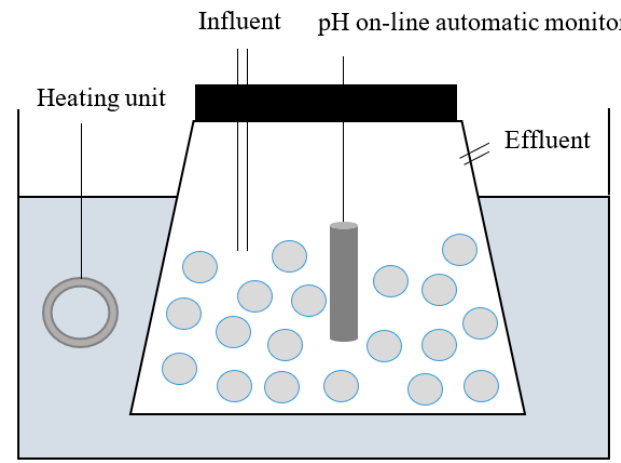
Figure 1. Schematicdiagramshowingtheexperimentalanaerobicammoniumoxidation(anammox)reactor. Figure 1. Schematic diagram showing the experimental anaerobic ammonium oxidation (anammox) reactor.